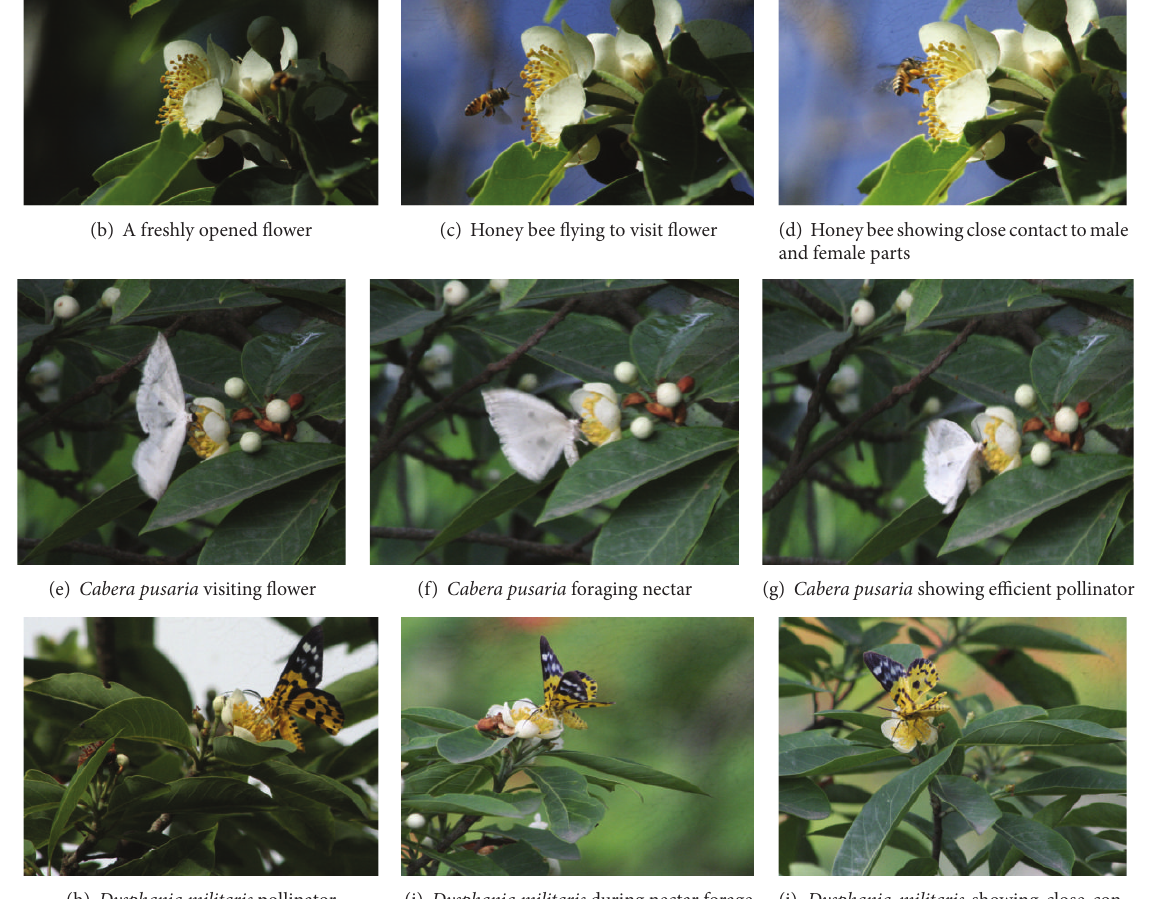
Figure 4: Different pollinators of Schima wallichii